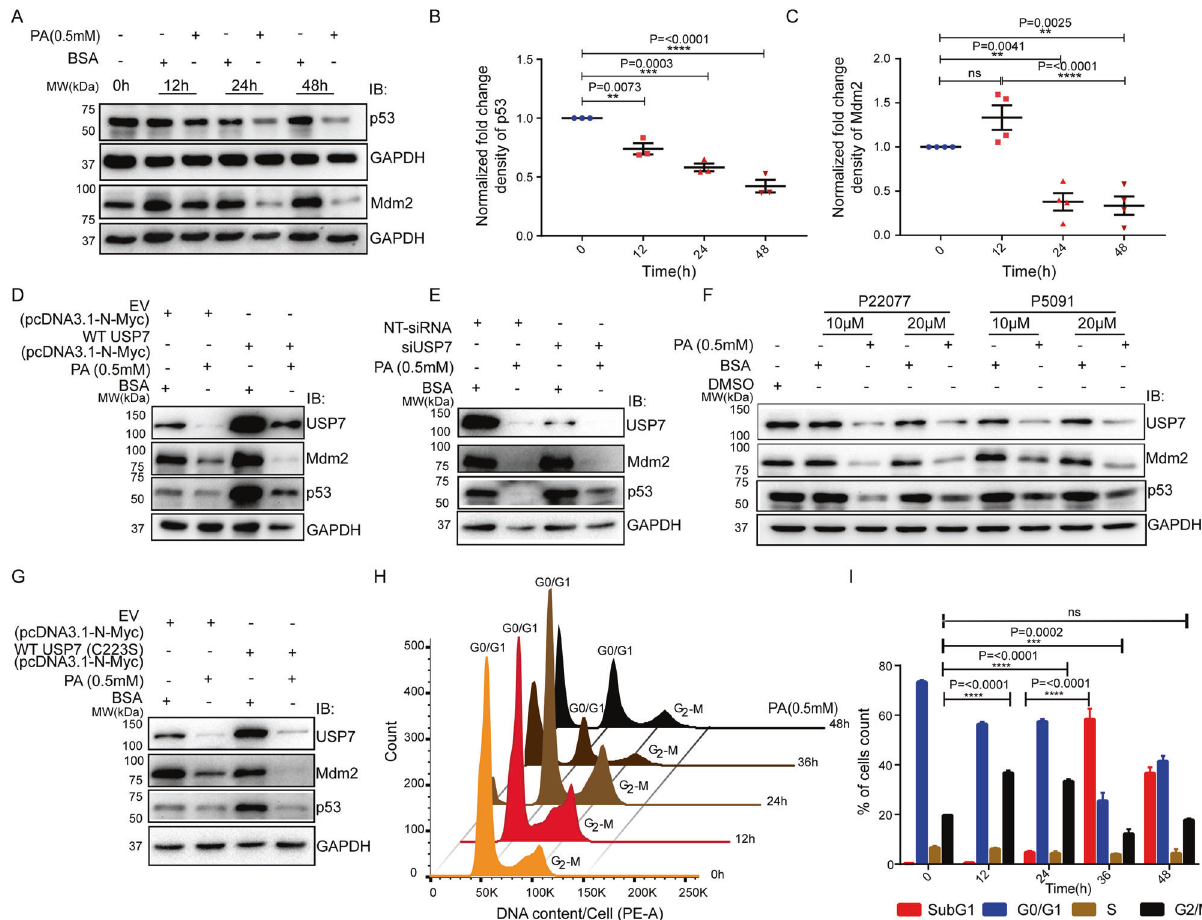
Fig. 3 Palmitic acid drives cell fate via downregulation of p53. PA ef fi ciently downregulates the expression of p53 and Mdm2. Western blot of total HepG2 cell lysate from control vehicle (BSA) and 0.5 mM PA in three different time points (12, 24, and 48 h). 0 h lysate put as a healthy cell condition and immunoblotted against p53 and Mdm2 ( A ). GAPDH was used as a loading control. Proteins were quanti fi ed as a normalized fold change density compared to individual BSA-treated conditions of a particular time point ( B , C ). Ordinary one-way ANOVA followed